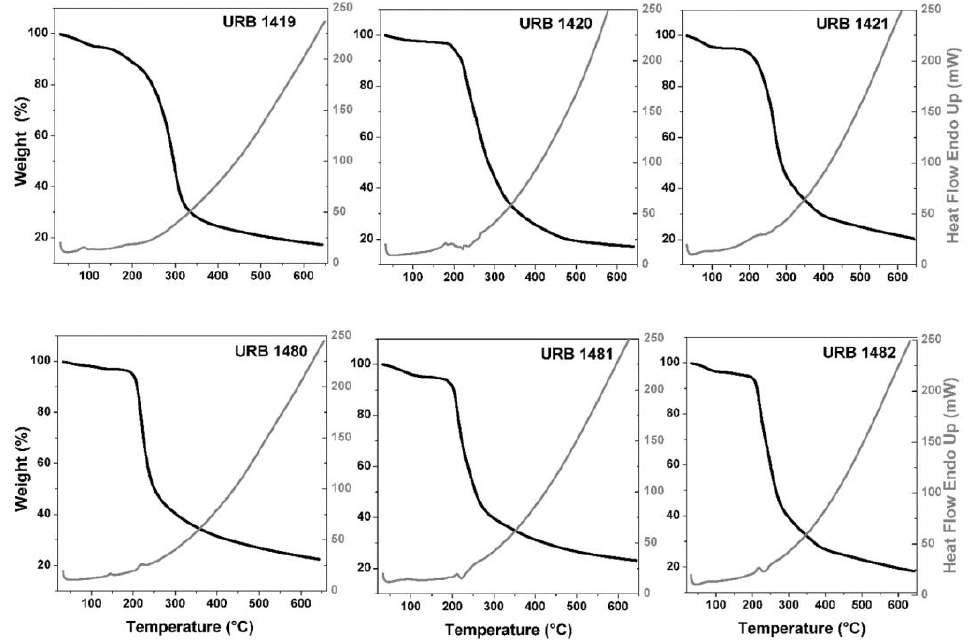
Figure 1. TGA and DTA of lactose-based surfactants (URB1419–URB1421) and sucrose-based surfactants (URB1480–URB1482). The black line in all of the plots refers to the “weight” signal, while the gray line in all of the plots refers to the “heat flow” signal.